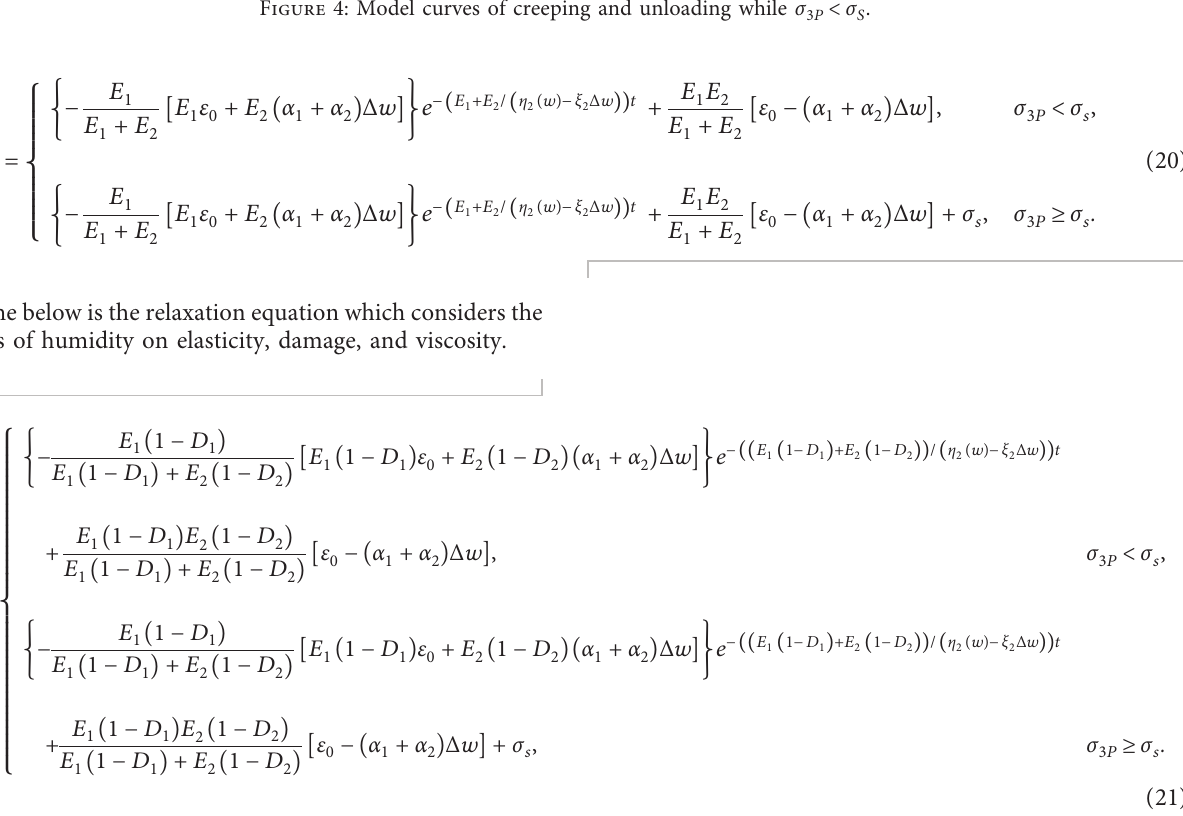
Figure 4: Model curves of creeping and unloading while σ